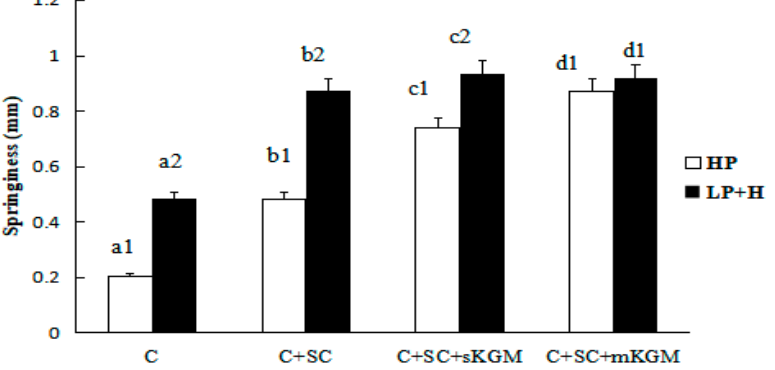
Figure 2. Effects of addition of various levels of SC and KGM on the springiness of different gels.